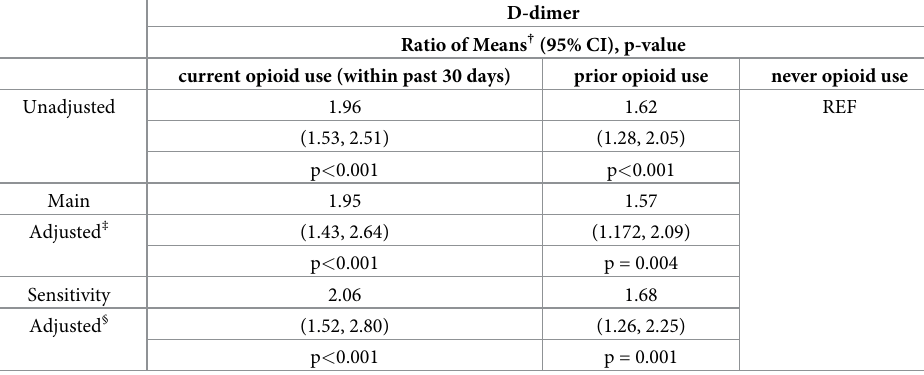
Table 4. Association between opioid use category and plasma concentrations of D-dimer among a cohort of Rus- sian PLWH (N = 346). D-dimer Ratio of Means † (95% CI), p-value current opioid use (within past 30 days) prior opioid use never opioid use Unadjusted 1.96 1.62 REF (1.53, 2.51) (1.28, 2.05) p < 0.001 p < 0.001 Main 1.95 1.57 (1.43, 2.64) (1.172, 2.09)Adjusted ‡ p = 0.004 Sensitivity